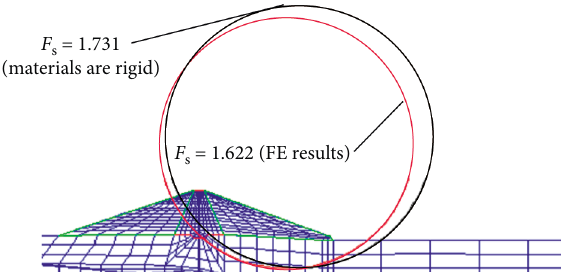
Figure 12: The most dangerous sliding surface and safety factor of dam under the normal storage water level.